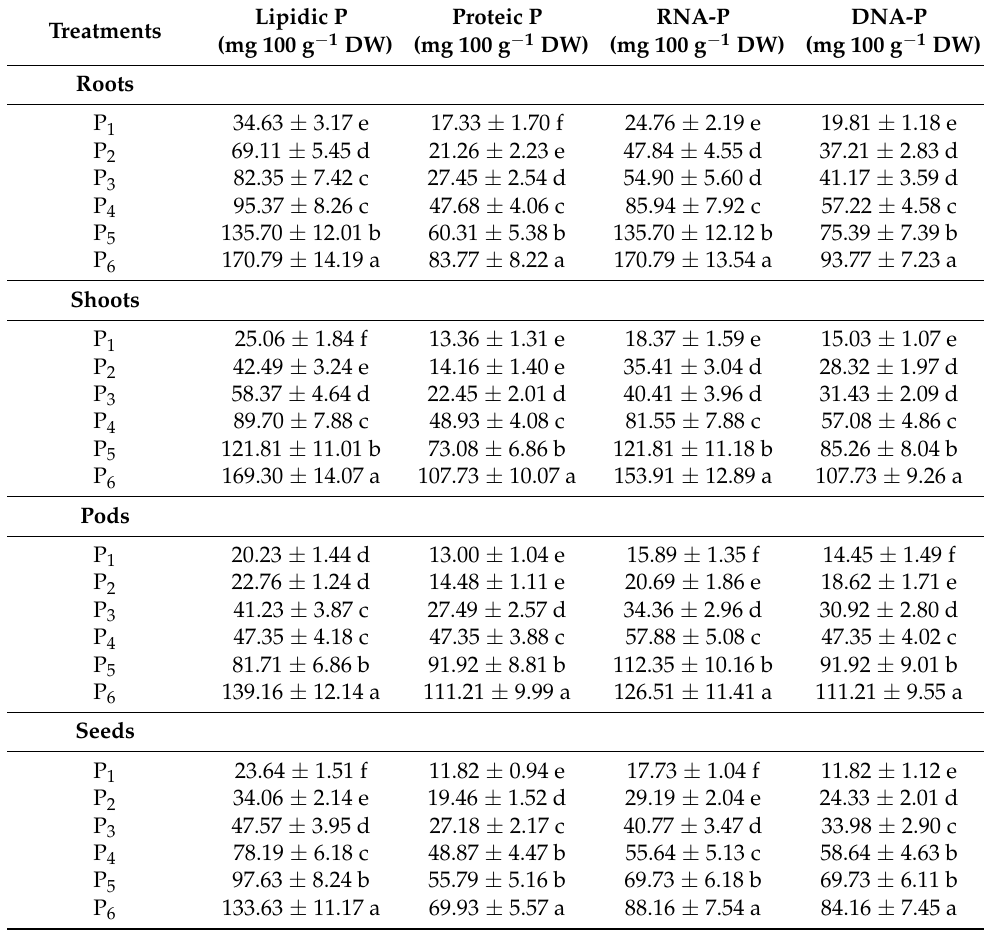
Table 4. Effects of different P treatments on lipidic P, proteic P, RNA-P and DNA-P in roots, shoots, pods and seeds of green bean plants at the end of the experiment. n = 6. Means ± standard deviation within columns with different lower-case letters are significantly different at p < 0.05 (One-way ANOVA and LSD